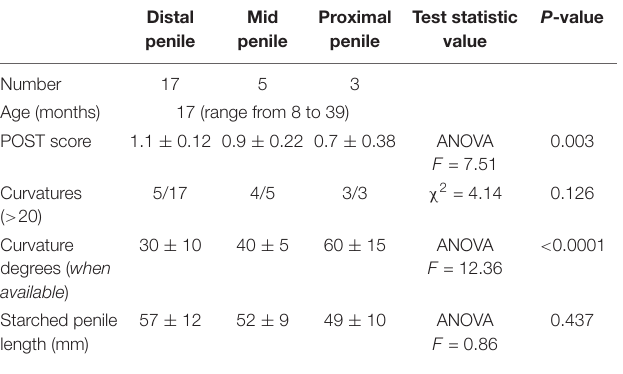
TABLE 1 | General and penile anthropometric values of study